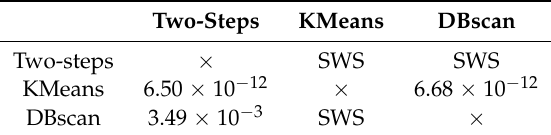
Table 21. p -values for instance f.5.